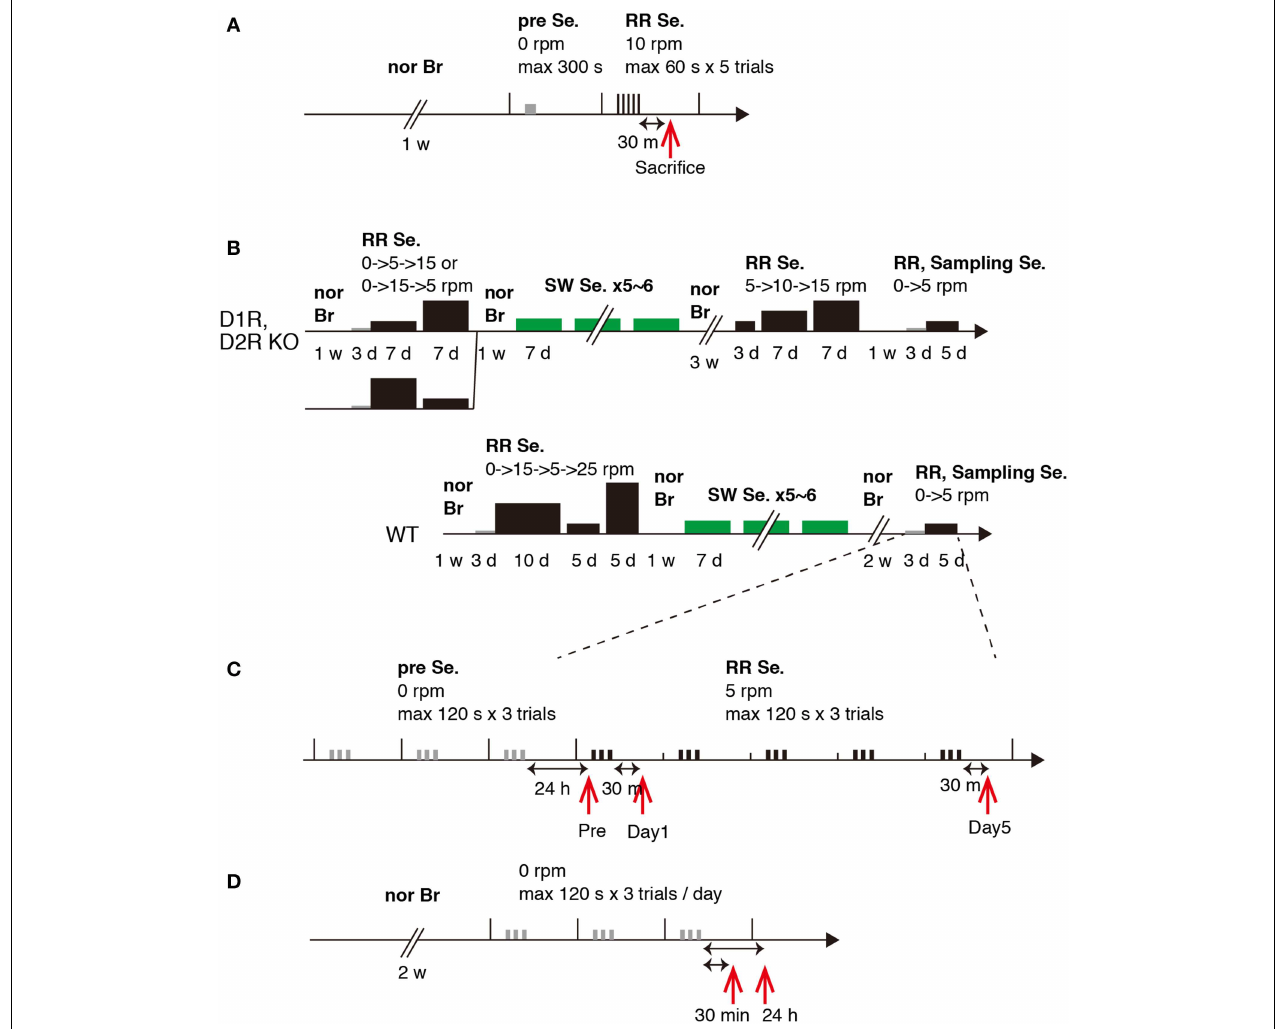
FIGURE 3 | Experimental schedules. Schematic experimental procedures for Experiments 1 and 2. (A) Experiment 1. (B) Experiment 2, WT, D1R KO, and D2R KO mice, training schedule. (C) Experiment 2, sampling schedule. (D) Experiment 2, 30min and 24h after stationary rota-rod task.